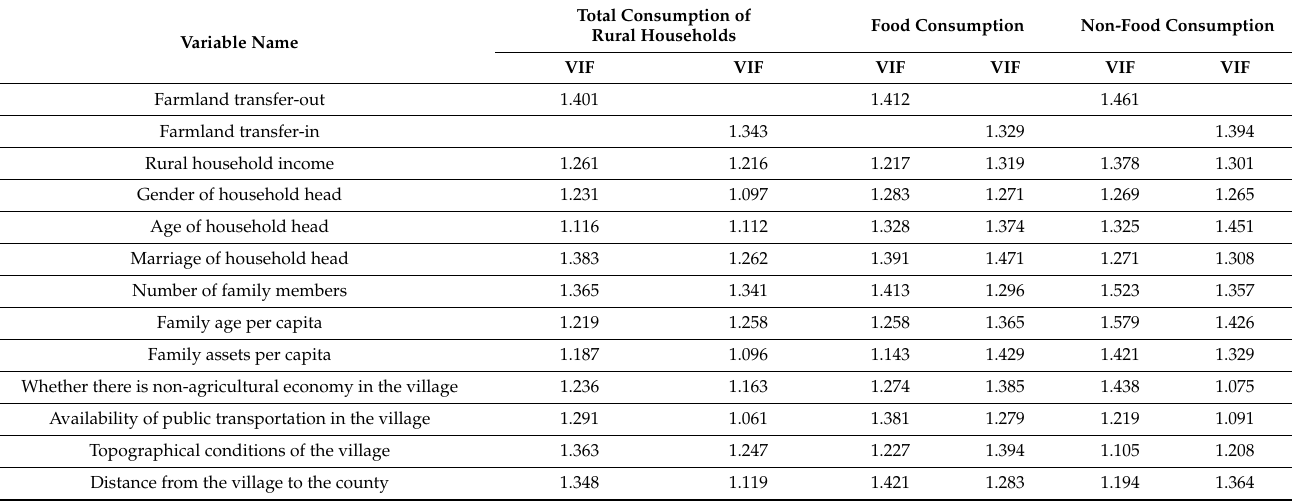
Table 2. Multicollinearity